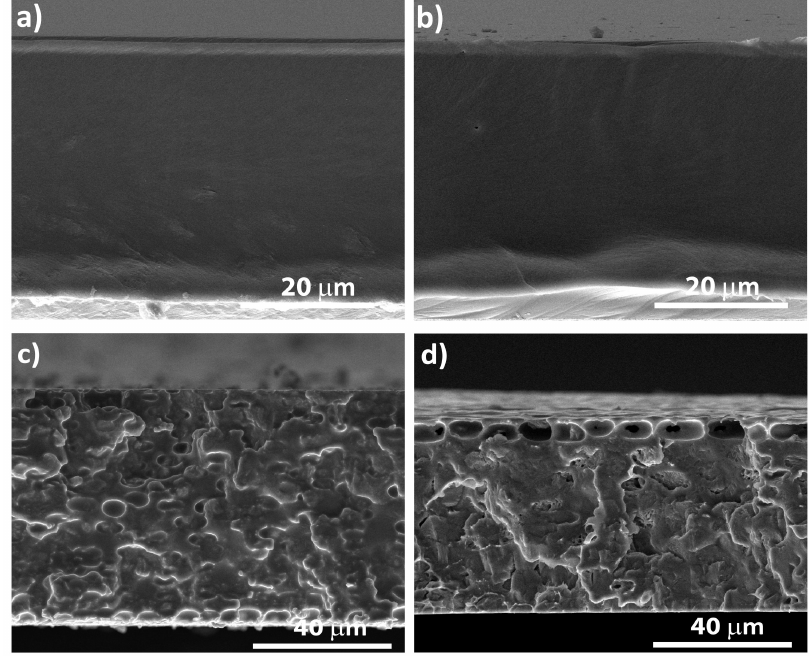
Figure 2. Cross-section SEM images of the PLLA-based films: ( a ) PLLA-DT25, ( b ) PLLA-DT50, ( c ) PLLA / [Emim][TFSI]-DT25 and ( d ) PLLA /